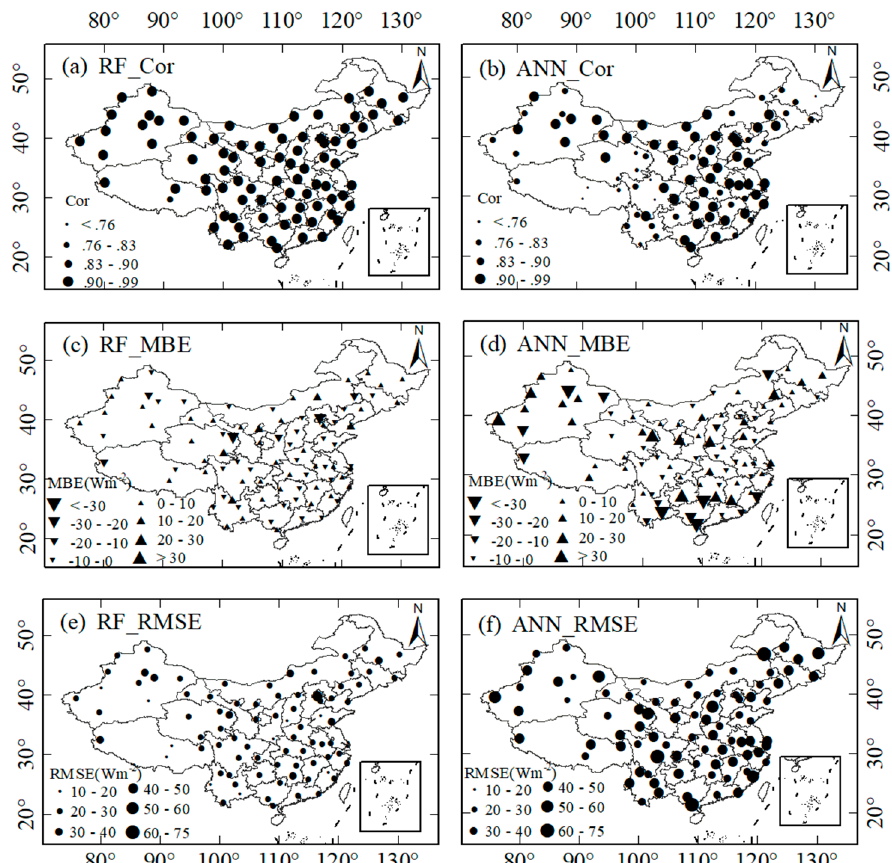
Figure 15. Spatial distribution of accuracy of R S estimates from Himawari-8 AHI data based on two machine learning methods at a daily time scale at the CDC / CMA stations from February to May 2016: panels ( a , b ) are the R between ground measurements and estimates from the RF and ANN methods, respectively; panels ( c , d ) are the MBE and panels ( e , f ) are the RMSE for two methods, respectively.